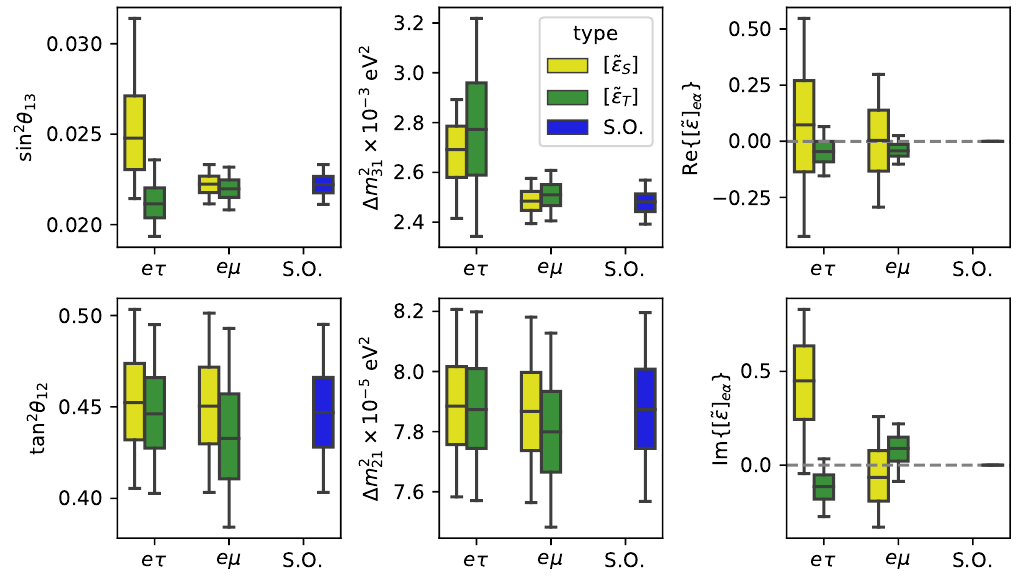
Figure 2 . The box plot for the distributions of the parameters. We show the median, the first and third quartile boxes, and the 5% and 95% percentiles for the whiskers ( ≈ 90%